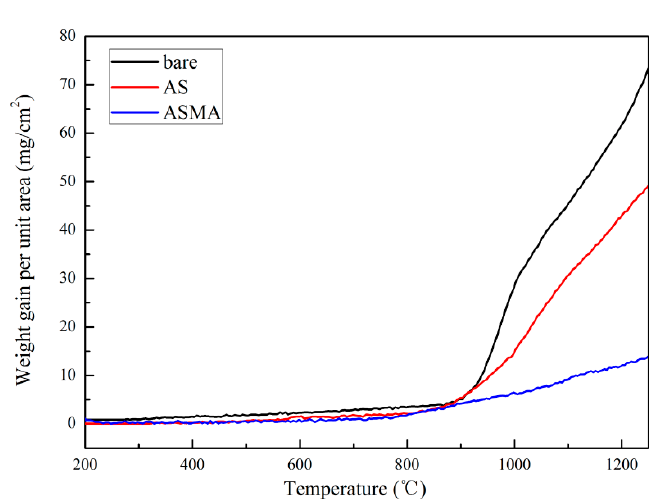
Figure 4. Results of non-isothermal kinetics.